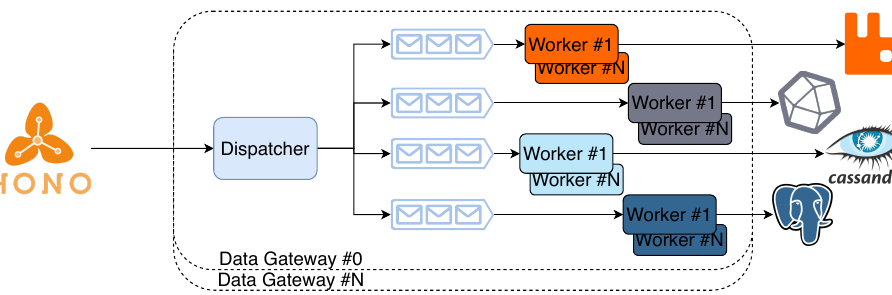
Figure 3. High-level architecture of the Data Gateway